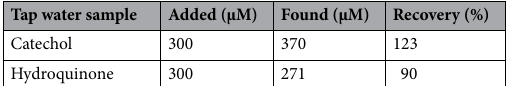
Table 2. Detection of both CC and HQ in tap